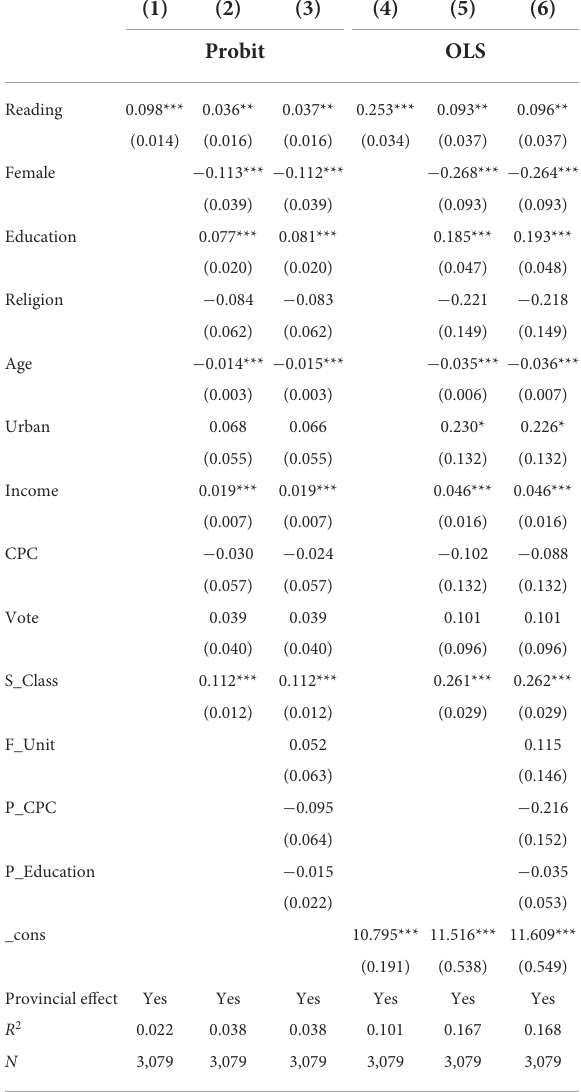
TABLE 2 Effect of reading habits on physical and mental health of the